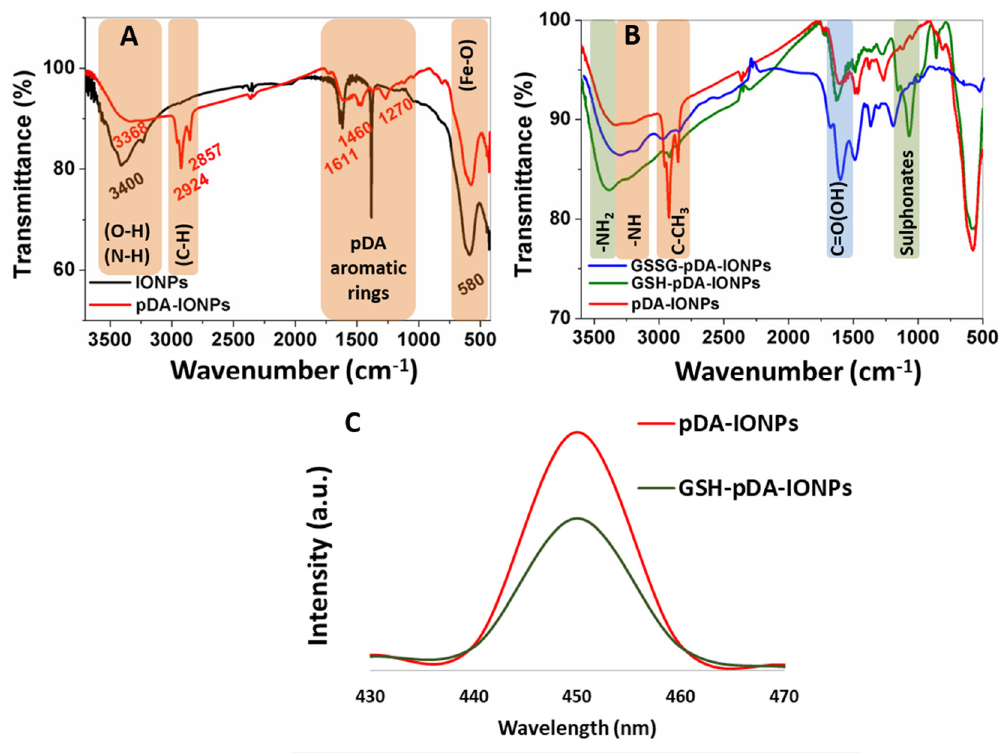
Figure 3. ( A , B ) Fourier transform infrared (FTIR) spectra showing the successful conjugation of pDA and GSSG molecules on IONPs; and ( C ) fluorescence spectra of pDA-IONPs and GSH-pDA-IONPs with λ excitation = 400 nm, λ emission = 450 nm.